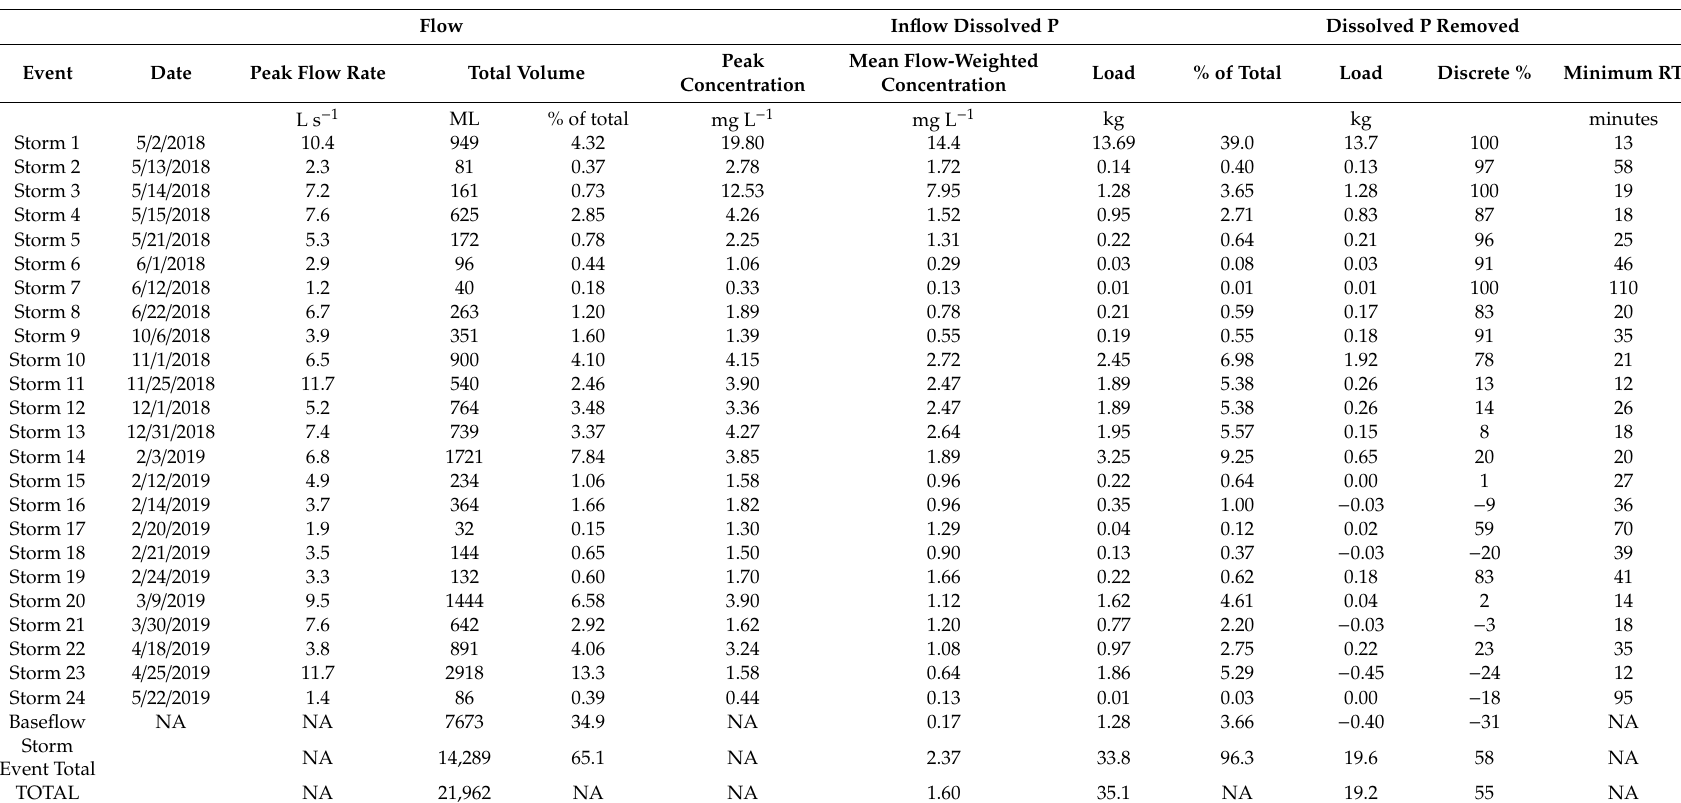
Table 2. Flow characteristics, dissolved phosphorus (P) concentrations and loads, P removal, and distribution of flow volume and P among individual precipitation-induced events and baseflow for the subsurface tile drain P removal structure shown in Figure 1. RT: retention time. NA: not